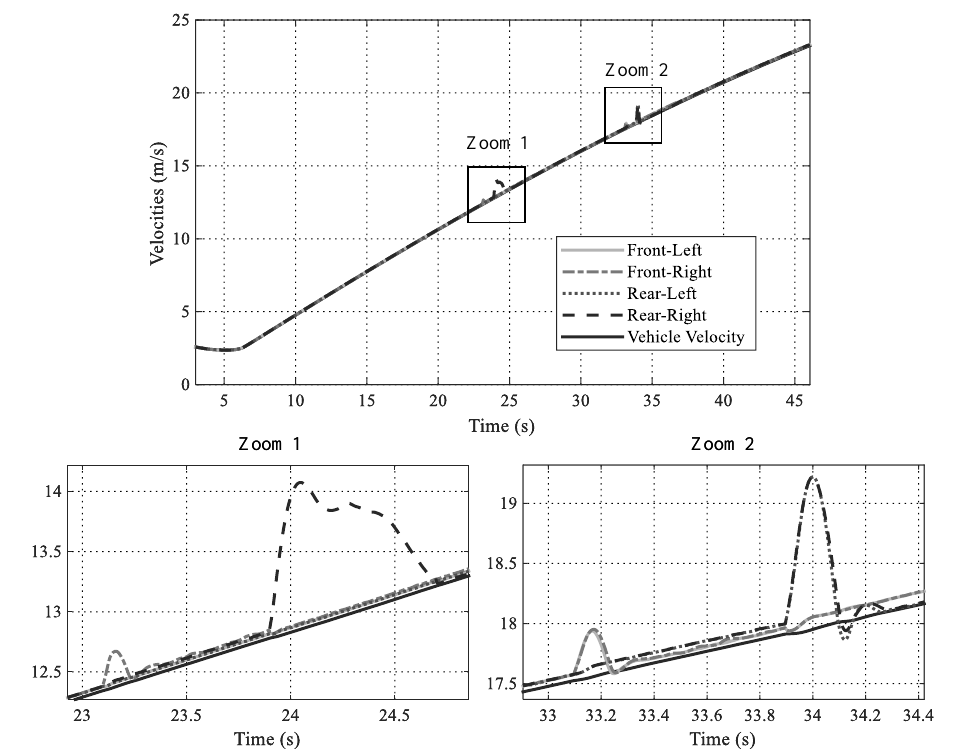
Figure 23. Wheel and Vehicle Velocities. The Zoom 1 is associated with Scenario 2 and the Zoom 2 is for Scenario 3.